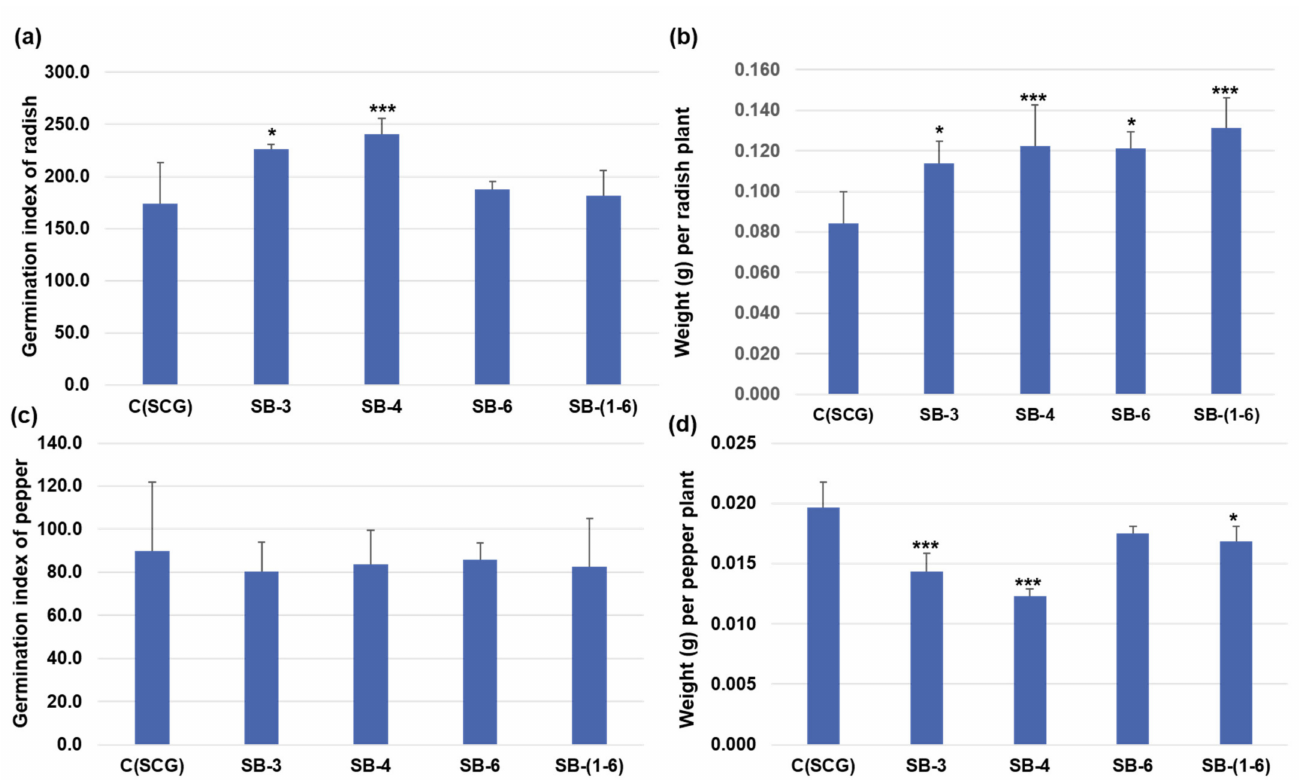
Figure 2. Effects of potential plant growth-promoting bacteria grown on SCG extract on the growth of radish plant ( a , b ) and pepper plant ( c , d ). SB-(1–6) indicates the mixed culture of strains SB-1, SB-2, SB-3, SB-4, SB-5, and SB-6. * indicates the significance of the treatment comparing with the control; *— p < 0.05; ***— p <